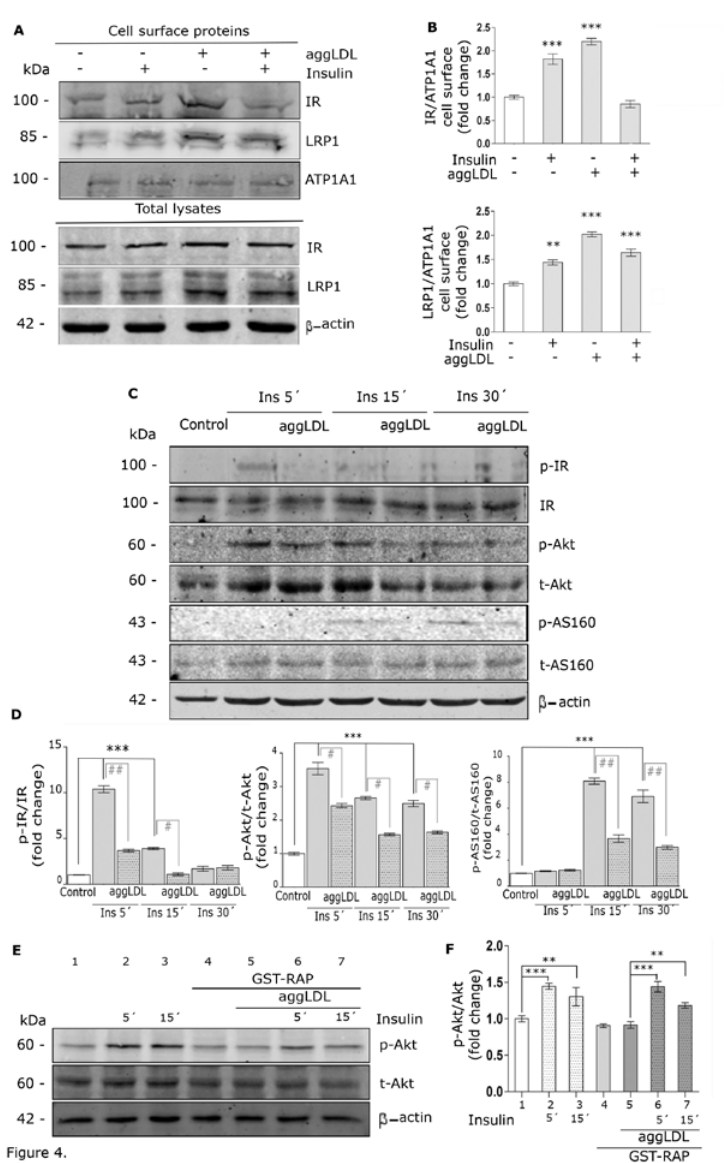
Figure 4. LRP1 and IR protein levels in the PM and insulin-induced intracellular signaling activation in HL-1 cells. ( A ) Biotinylation assay of surface LRP1 and IR proteins. Cells were incubated with 100 µg/mL aggLDL for 8 h and subsequent stimulated with 100 nM insulin for 30 min. Biotinylated proteins were isolated from protein extracts through streptavidin-conjugated bead pull-down. The lower panel of the Western blot shows the detection of LRP1 and IR in total lysates, where 20% of the total protein content was loaded for the incubation with beads. Biotin-ATP1A1 and β -actin were used as protein loading controls of PM and total protein extracts, respectively. ( B ) Bar graphs show the mean ± SEM of the relative optical densities (O.D.) (referred to biotin-ATP1A1 as loading control of PM proteins) of the bands corresponding to LRP1 and IR of cell surface, expressed as fold change against the control (white bar). (***) ( p < 0.001) and (**) ( p < 0.01) indicate significant di ff erence respect to control. Three independent experiments were performed by triplicate. ( C ) The Western blot assay of phosphorylated IR (p-IR), Akt (p-Akt) and AS160 (p-AS160) relative to each total protein in HL-1 cells treated with aggLDL as above and stimulated or not with 100 nM insulin for 5 min to 30 min. The immunodetection of β -actin was used as a protein loading control. ( D ) Bar graphs represent the densitometric quantification of the bands obtained in the Western blot results. Respective values were expressed as the mean ± SEM of the relative intensity of p-IR / IR, p-Akt / t-Akt or p-AS160 /